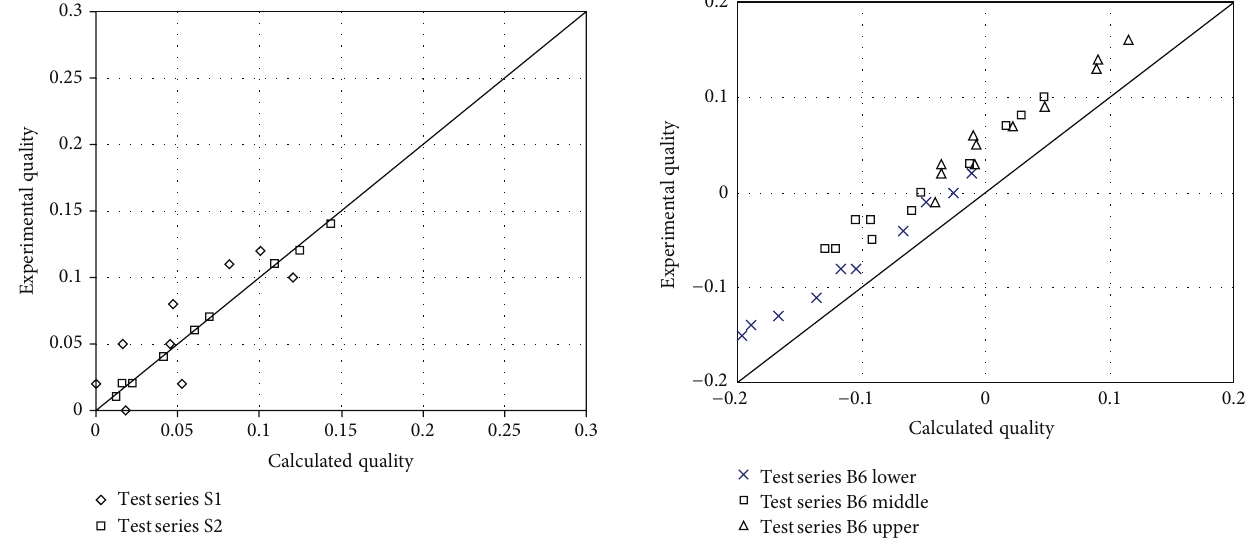
Figure 18: Deviation of measured quality from recalculated quality for test series